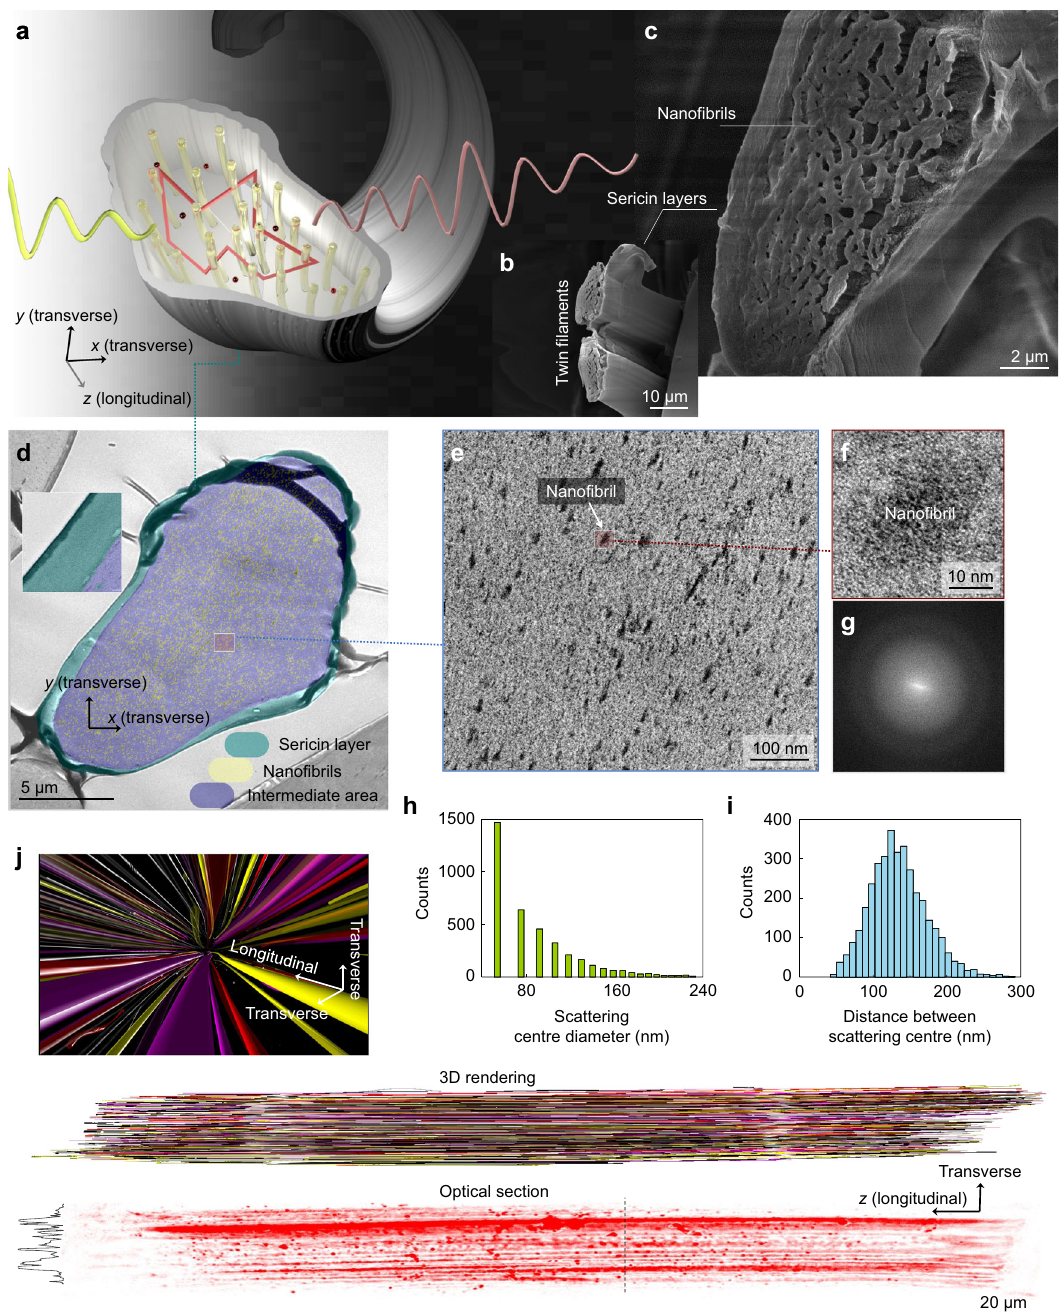
Fig. 1 Nano fi brillar structures in a silkworm silk fi bre. a 3D illustration of light localization in a single silk fi lament of nano fi brillar structures (yellow translucent cylinders). b , c SEM showing a freeze fractured edge of twin fi broin fi laments b and nano fi brils c . d – f TEM with different magni fi cations. The colour-coded overlay in d distinguishes nano fi brils, voids and sericin layers. The dark granule-like dots in e , f indicate nano fi brils. g 2D fast Fourier transforms of e . h , i Histograms of scattering centre size ( h ) and distance ( i ). j 3D rendering of reconstructed nano fi bril trajectories (cylinders) in a single fi lament (Supplementary Movie 1). Each connected component is labelled to a different colour. The 3D nano fi bril trajectories are reconstructed from z - stack re fl ectance confocal microscopy images (Olympus FV1000) of a sericin-removed silk fi lament (×60 water immersion objective, confocal aperture of 55 µ m, stack size of 7.5 µ m and step size of 100